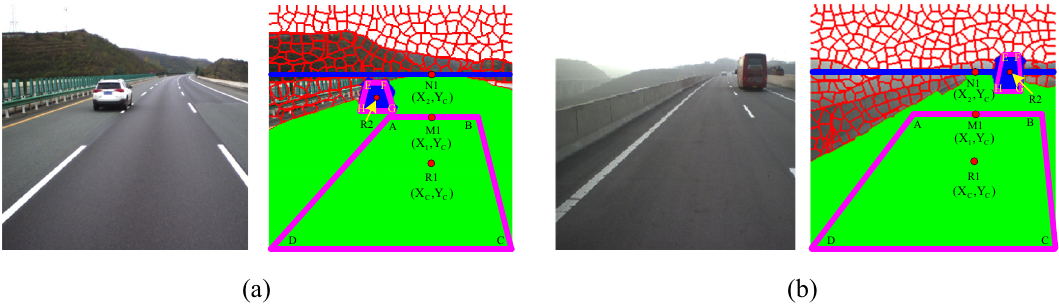
Figure 2. Definition of seed trapezoid for road and foreground regions. The green and blue colors denote the respective